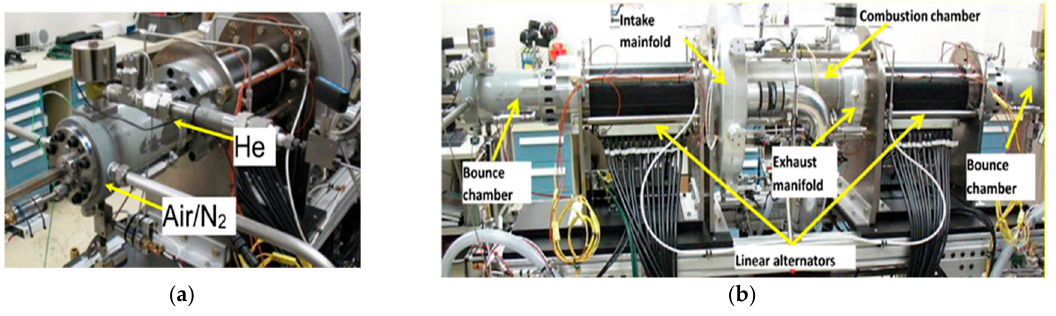
Figure 19. The prototype of opposed-piston FPLG. ( a ) Diagram of gas supply to bounce chamber; ( b ) Structure diagram of FPLG.